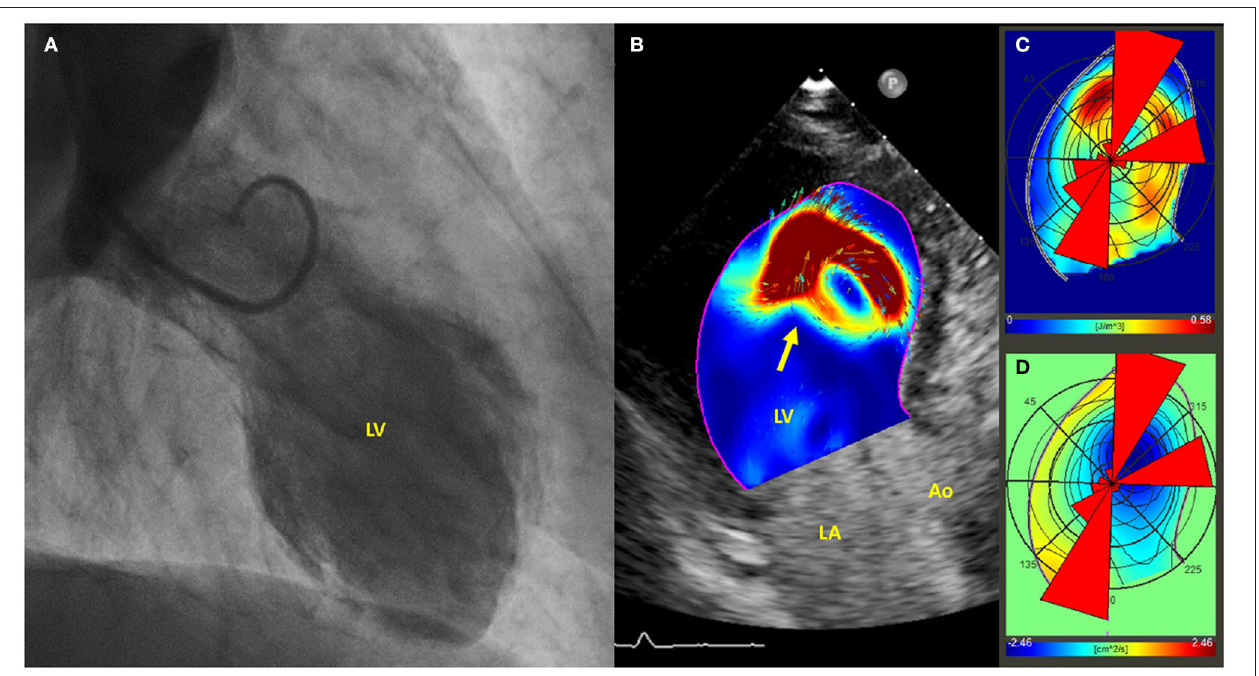
FIGURE 2 | (A) Left ventriculogram demonstrating apical ballooning of the left ventricle; (B) Echo-PIV analysis, revealing the presence of a single vortex, occupying the center of the left ventricle and non-interacting with others (arrow). (C,D) PIV derived polar histograms showing a relatively preserved base-apex flow direction. Adapted with permissions from Cimino et al. (43). Particle image velocimetry (PIV), left ventricle (LV), left atrium (LA), aorta